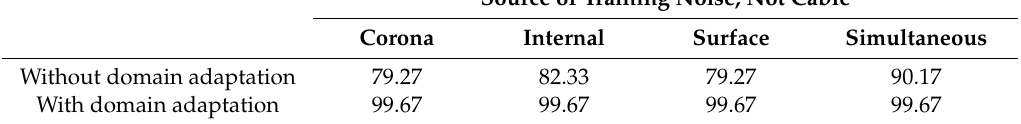
Table 5. Agreement in percentages between OCSVMs trained using default mode signals recorded at the cable experiment (rows) and OCSVMs trained using background noise recorded at other experiments (columns). The top row shows results without domain adaptation, while the bottom row incorporates a domain adaptation consisting in tuning the value of ρ in the OCSVMs learned with noises of other experiments with the noise pulses recorded at the Cable. The test set includes both PD and noise recorded at the